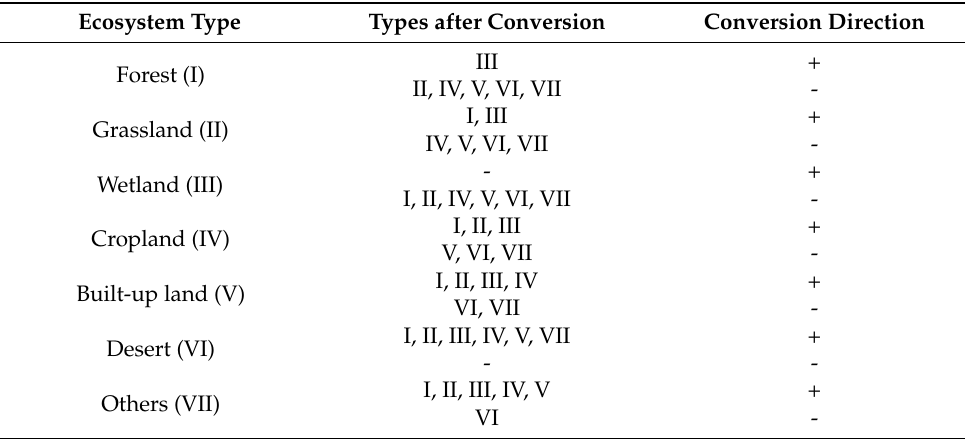
Table 3. Rules of forward/reverse ecosystem